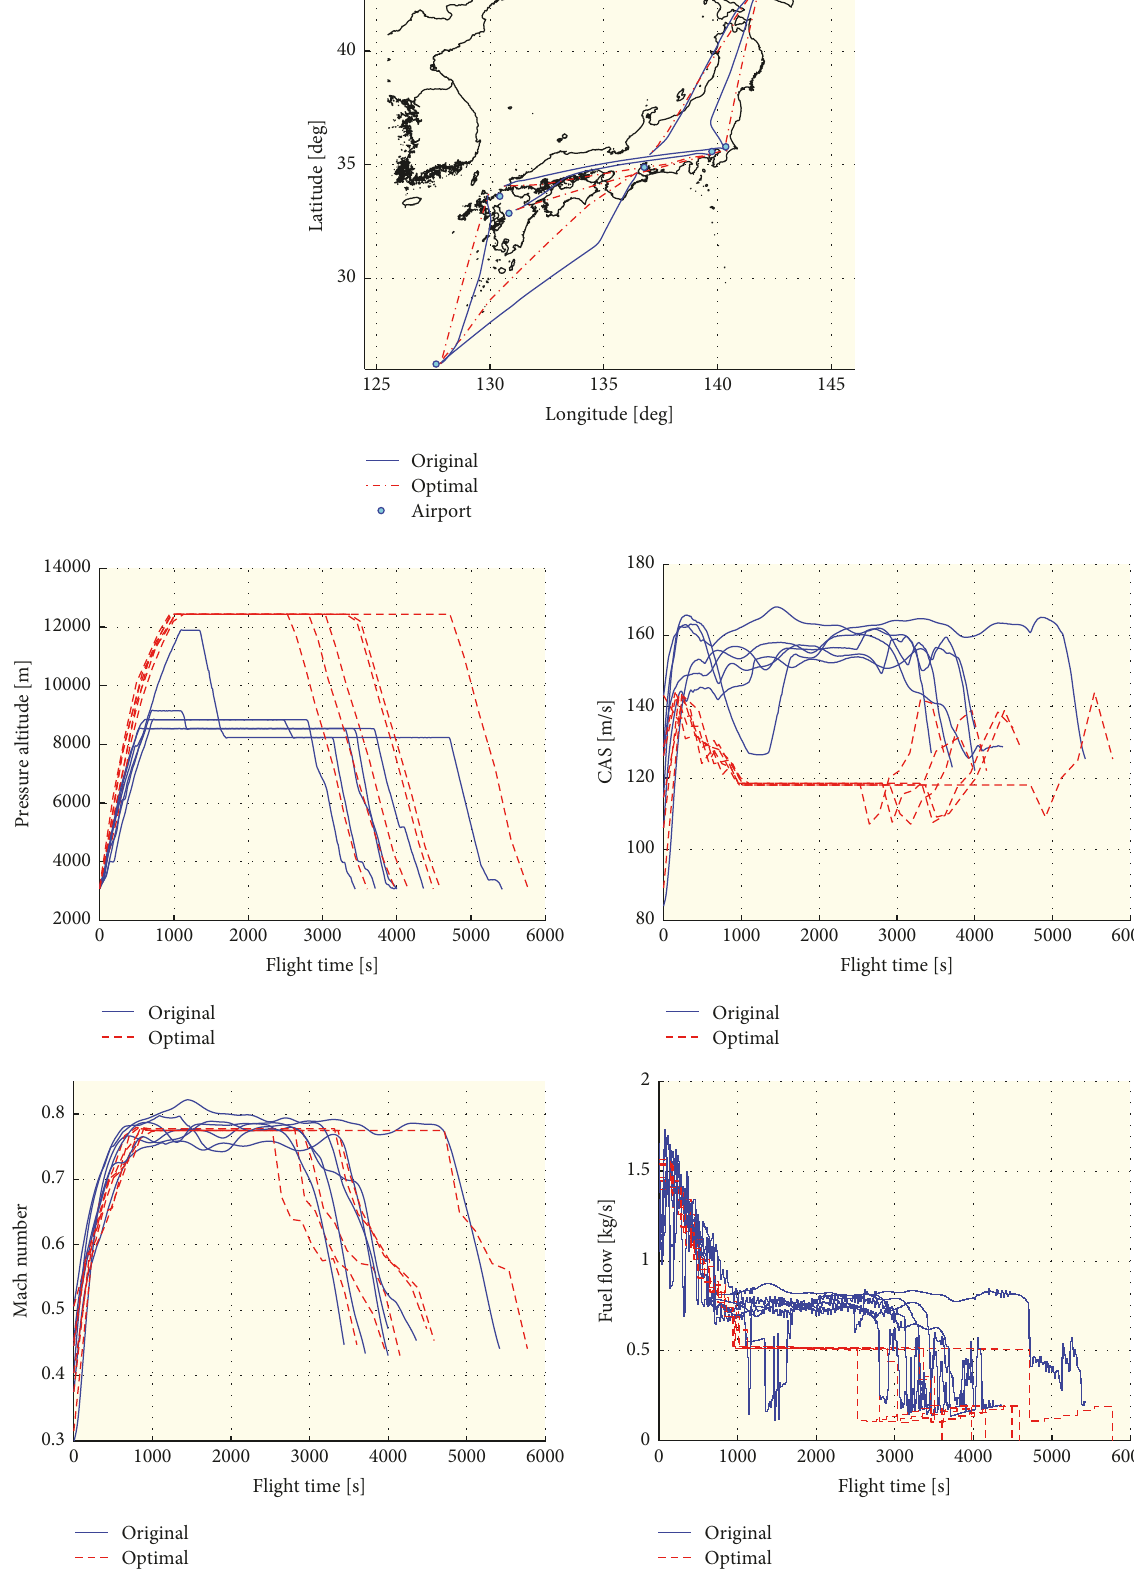
Figure 15: Flight state information of the nonoptimal cruise